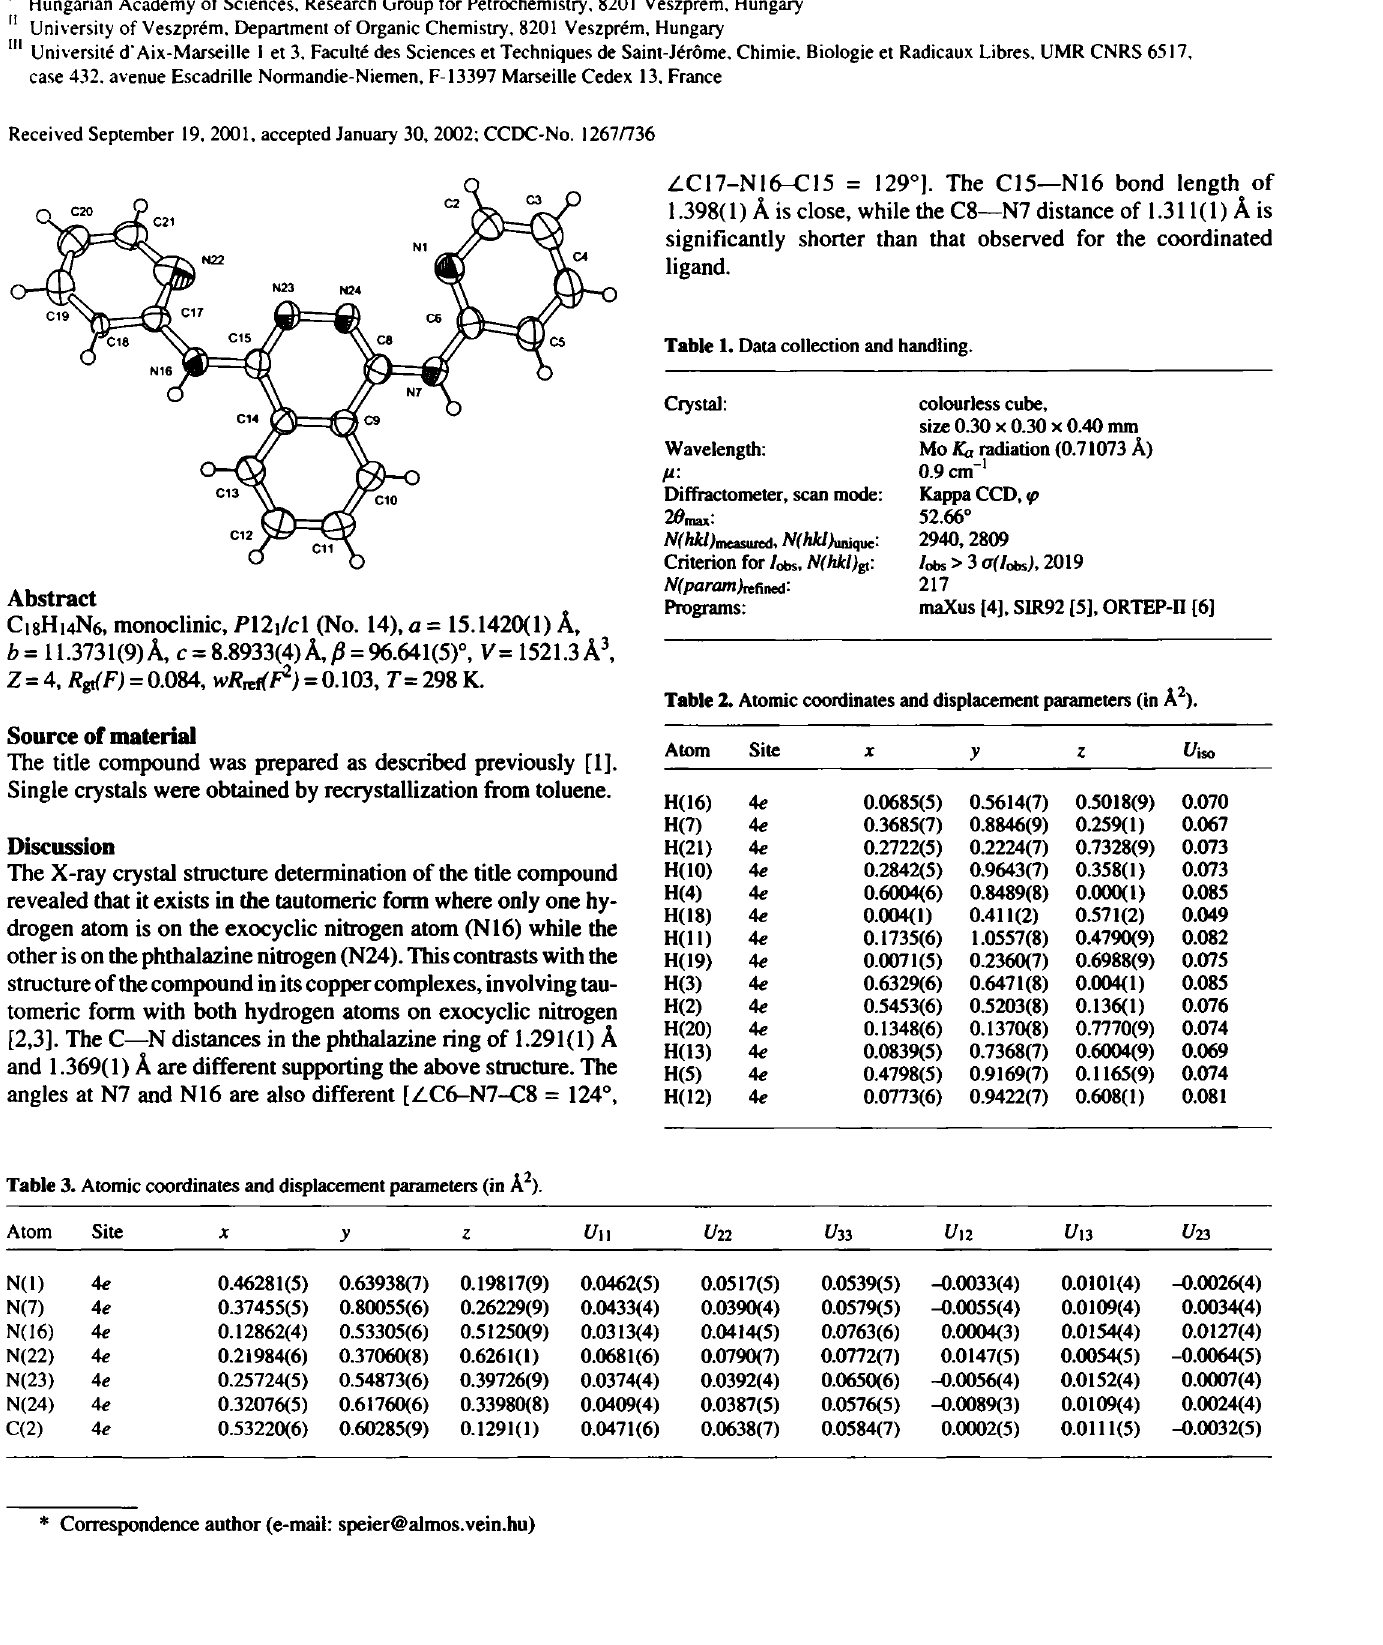
Table 1. Data collection and handling.